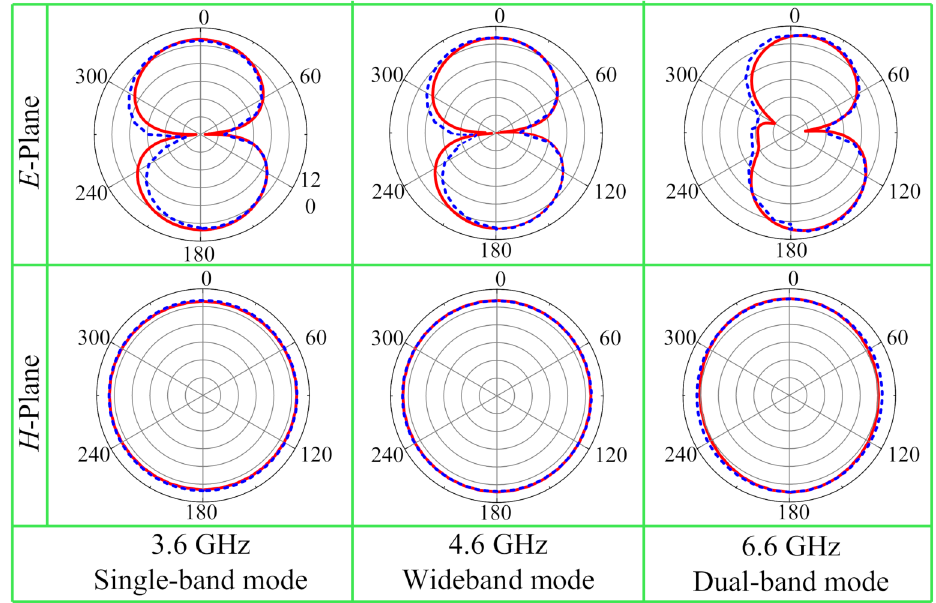
Figure 8. Measured and simulated radiation plots of the proposed antenna at various frequencies. The gain and radiation efficiency of the proposed antenna at different modes of operation are shown in Figures 9 and 10, respectively. The measured peak gain of 4.1 dBi